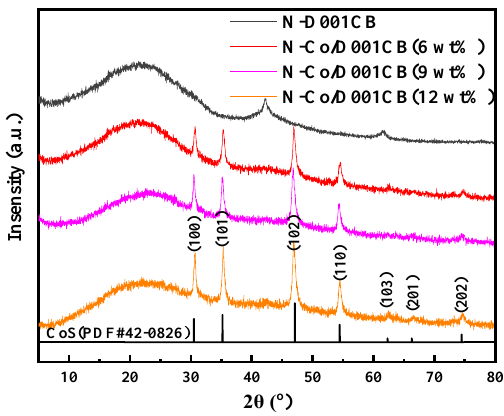
Figure 3. XRD of a nitrogen-doped carbon ball with different cobalt loadings.